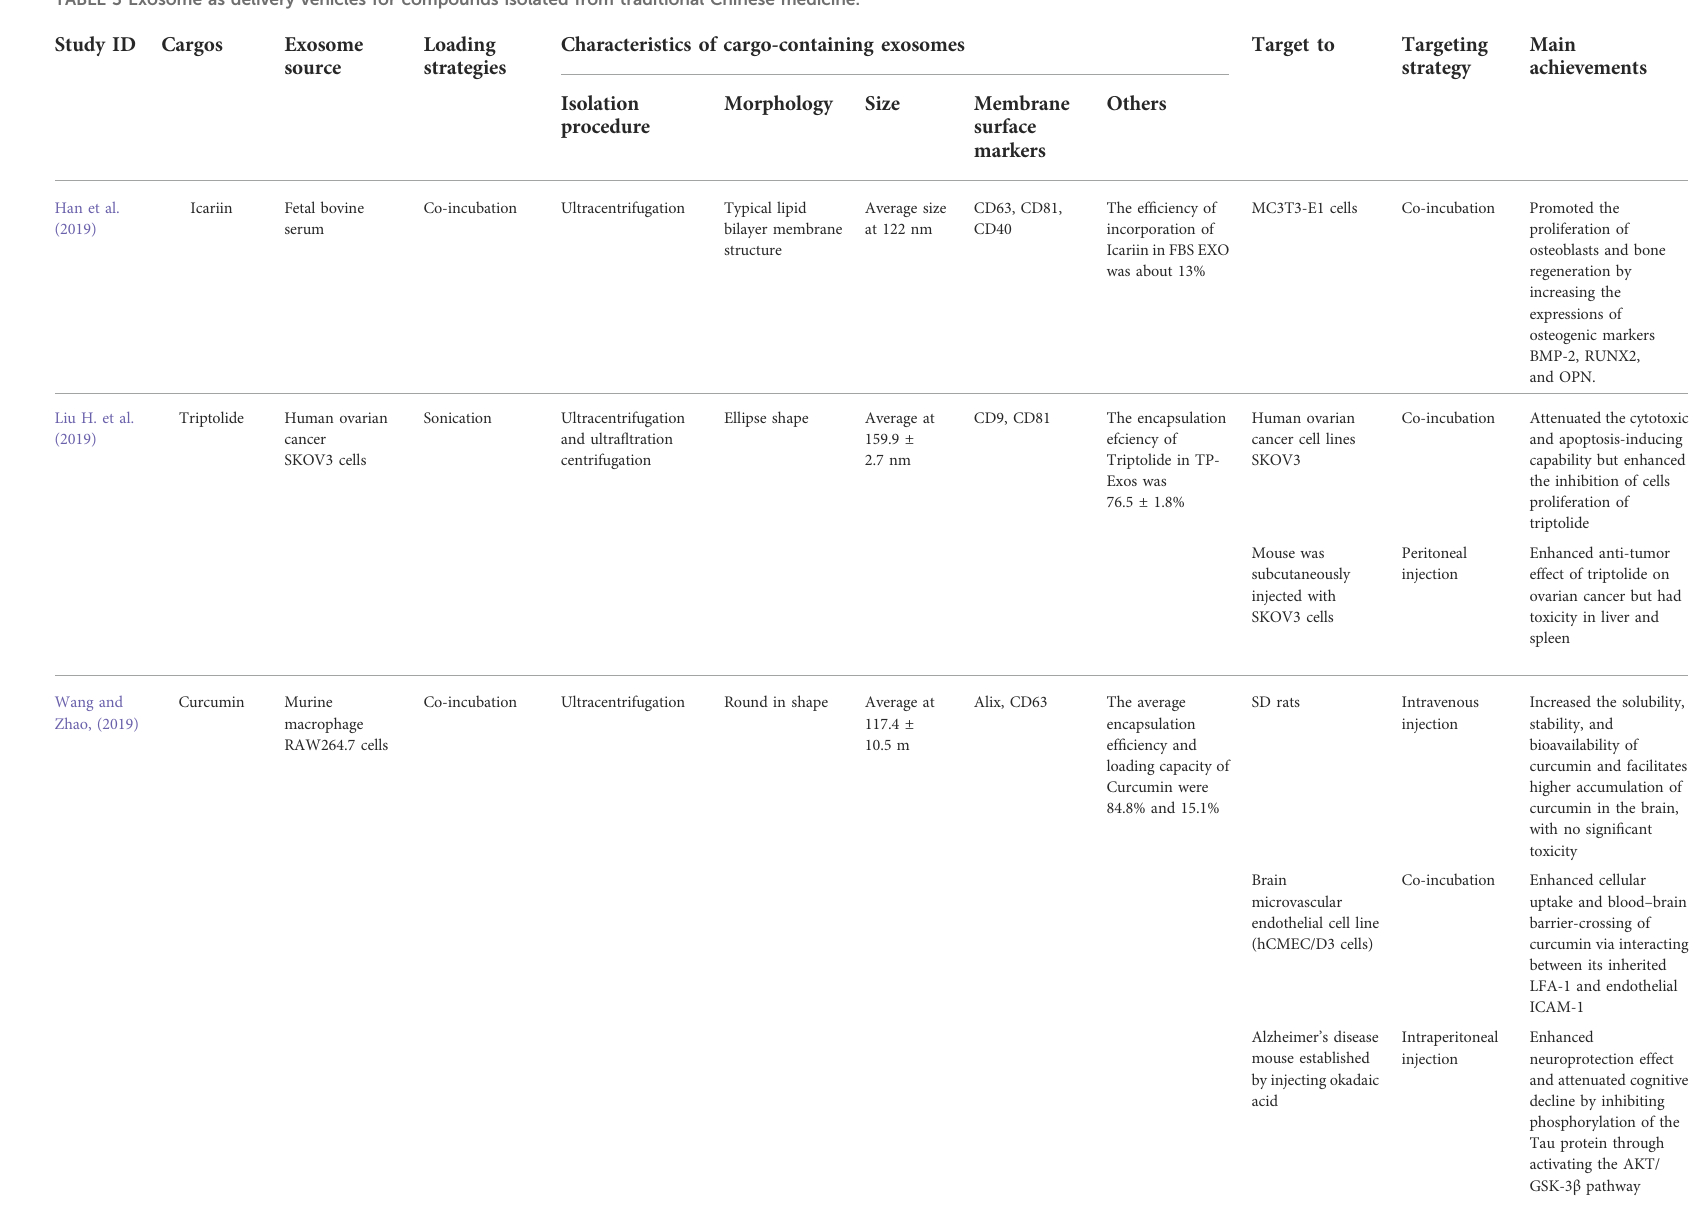
TABLE 3 Exosome as delivery vehicles for compounds isolated from traditional Chinese